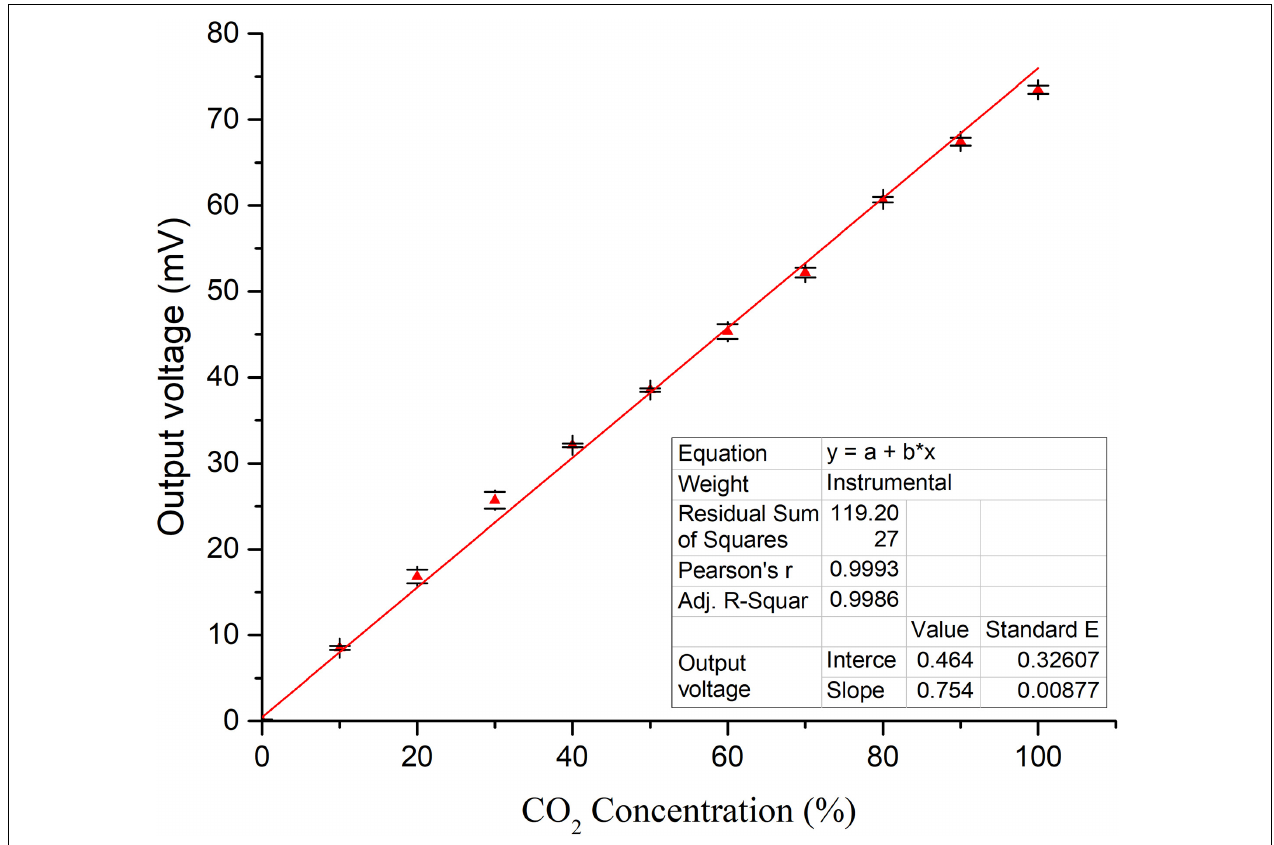
FIGURE 9 | Input and output characteristic curve of